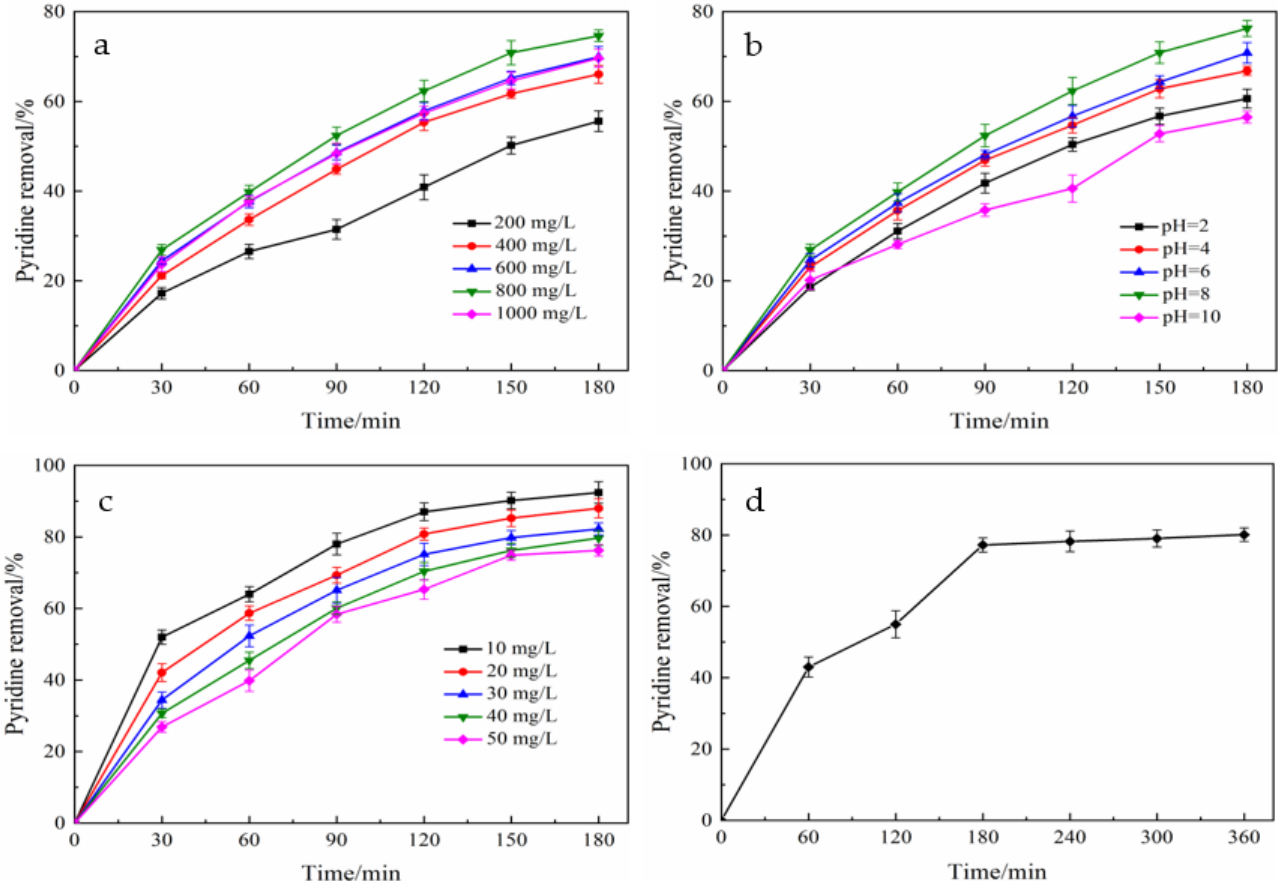
Figure 5. Influencing factors of photocatalytic degradation: ( a ) photocatalyst dosage (initial concentration 50 mg/L, pH = 7, light intensity 560 W, temperature 35 °C, photocatalytic time 3 h); ( b ) pH (initial concentration 50 mg/L, photocatalyst dosage 800 mg/L, light intensity 560 W, temperature 35 °C, photocatalytic time 3 h); ( c ) initial concentration (pH = 8, photocatalyst dosing 800 mg/L, light intensity 560 W, temperature 35 °C, photocatalytic time 3 h); and ( d ) photocatalytic time (initial concentration 50 mg/L, pH = 8, photocatalyst dosing 800 mg/L, light intensity 560 W, temperature 35 °C).